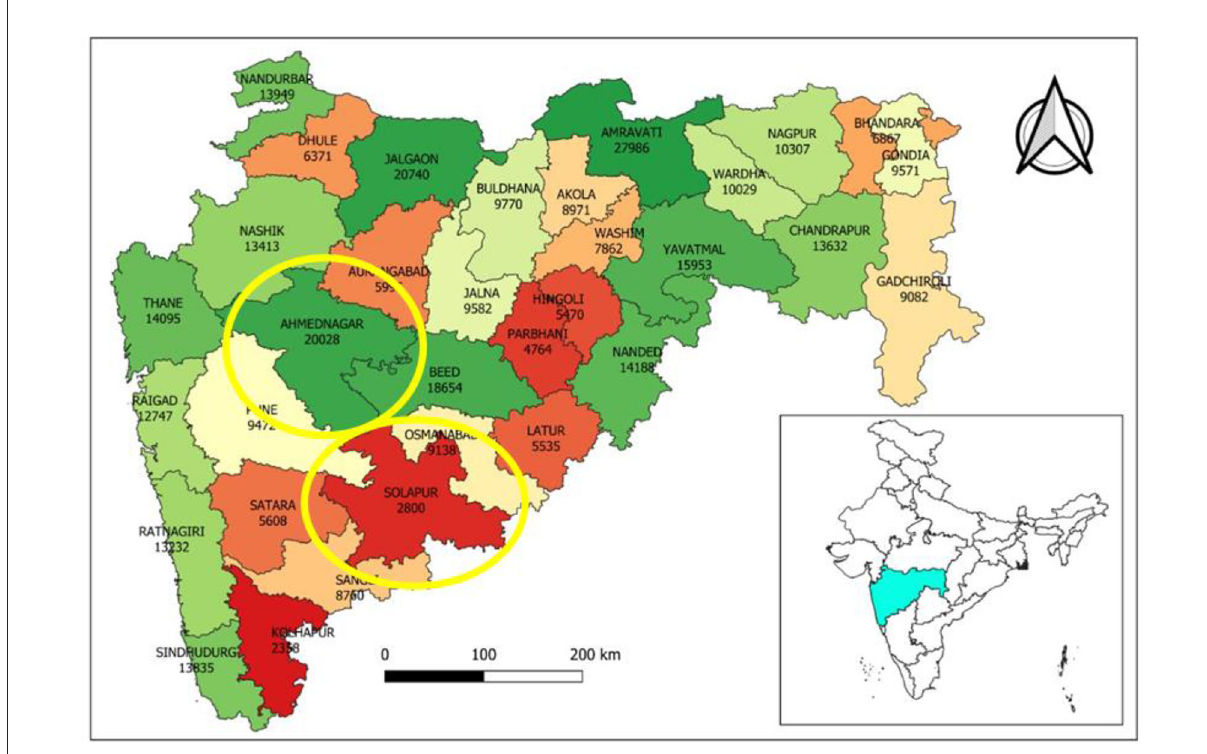
FIGURE9 District-wise MGNREGS-IWMP projects completed from 2007 to 2020 highlighting the applied (green) and controlled (brown) sites in yellow